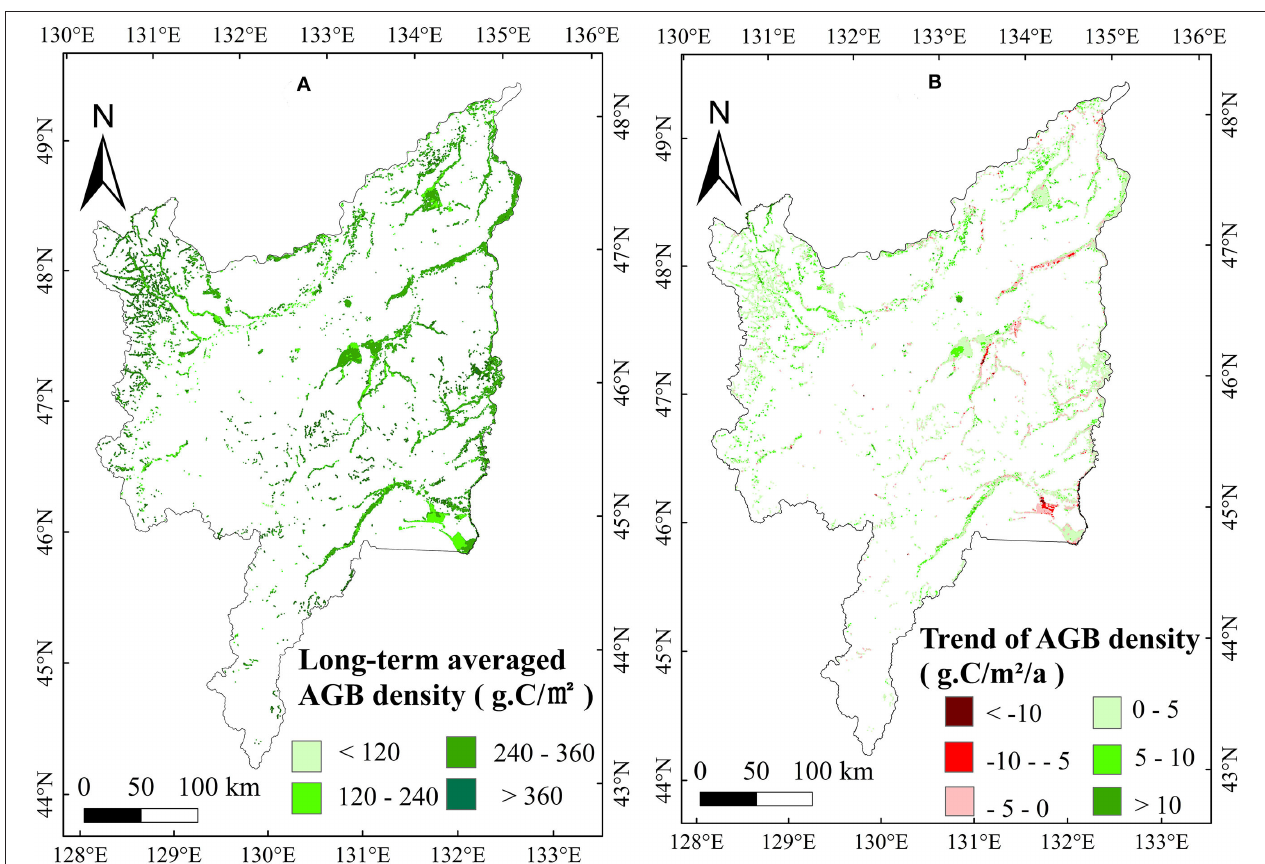
FIGURE 3 | Distributions of long-term average AGB density (g · C/m 2 ) (A) and change trends of AGB density (g · C/m 2 /a) (B) in the marsh of the Sanjiang Plain from 2000 to